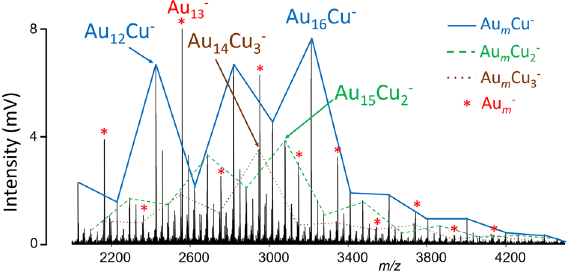
Figure 4. LDI mass spectra of {AuNPs, Cu-MOF} composite showing the formation of Au m Cu n − clusters. Conditions: negative reflectron ion mode, laser energy 170 a.u. Solid lines have no physical meaning and were used for the sake of clarity.